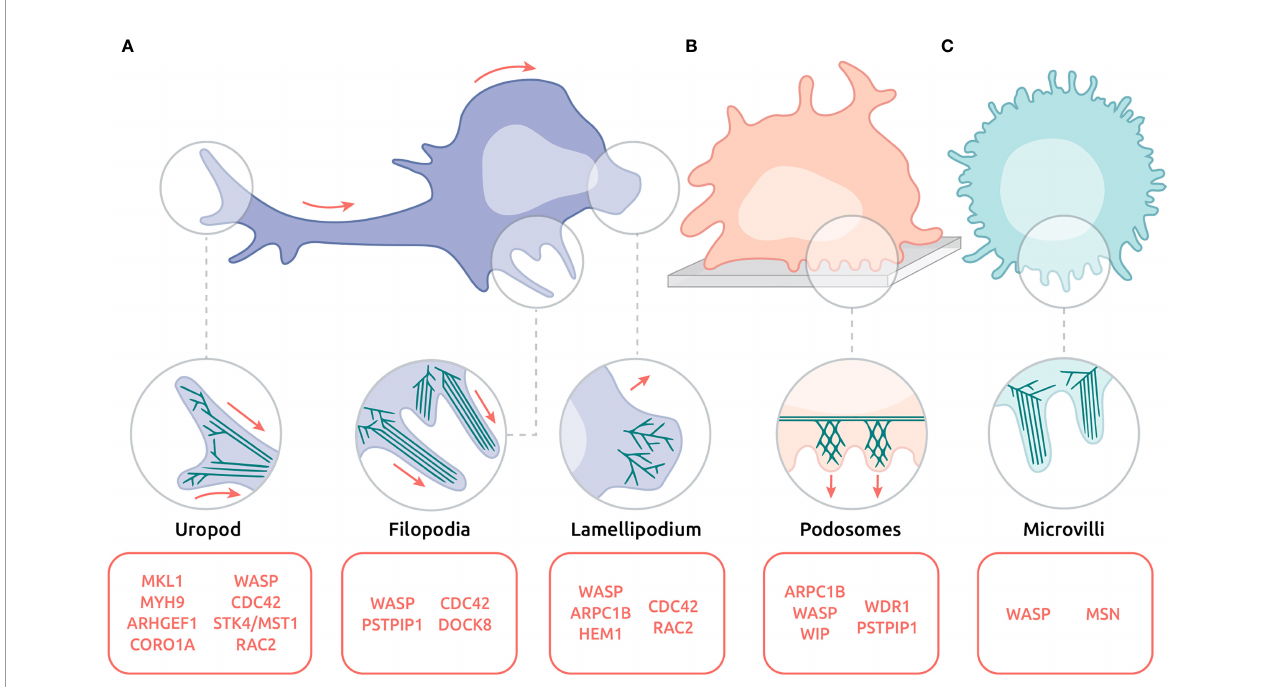
FIGURE 3 | Actin-based protrusions affected in actinopathies on the ultrastructural level. (A) Migrating lymphocyte with uropod, fi lopodia and lamellipodium. (B) Adhering DC emitting an array of podosomes. (C) Circulating neutrophil decorated with microvilli. Red arrows indicate direction of movement. Protein names listed in red indicate their involvement in the corresponding